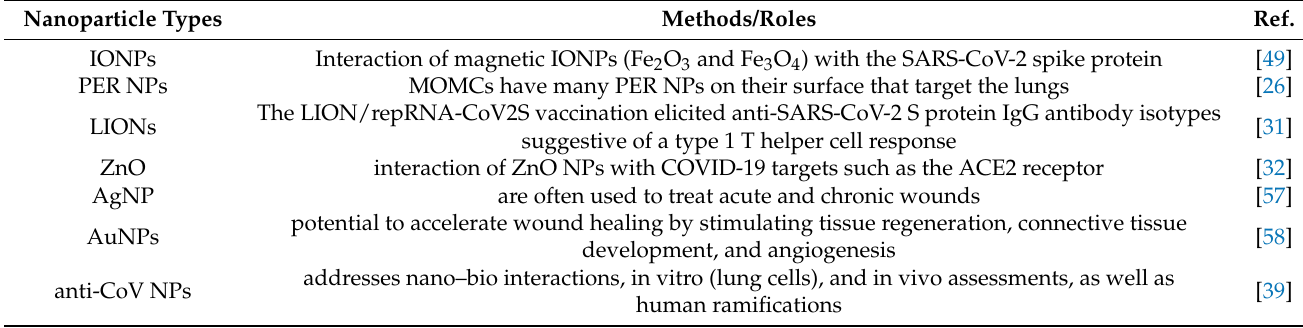
Table 2. Inorganic nanoparticle methods and roles in tissue regeneration. Nanoparticle Types